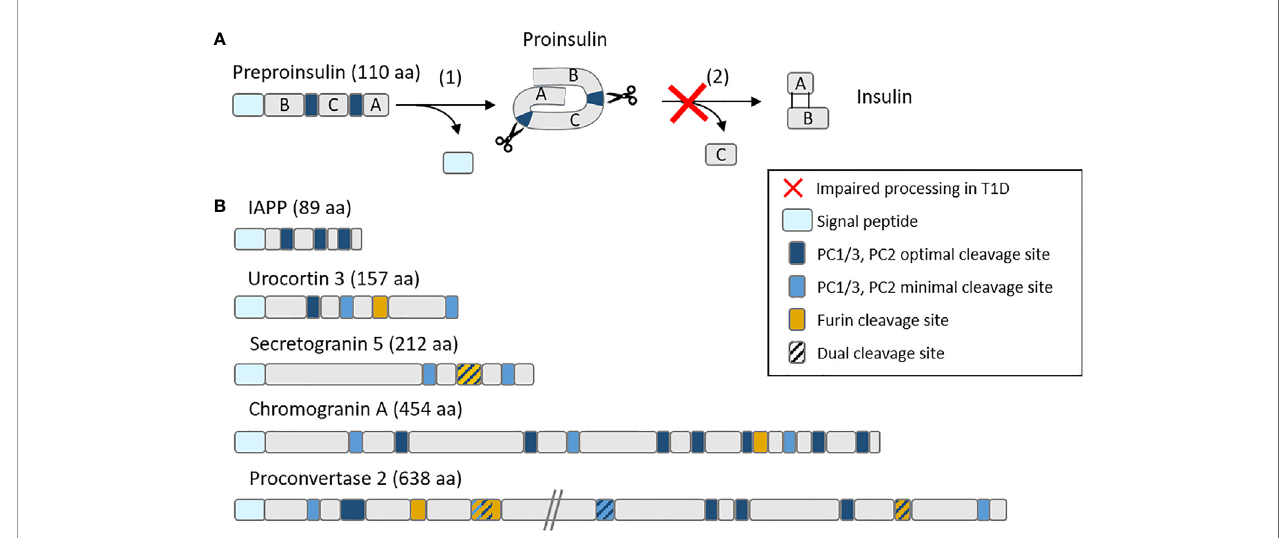
FIGURE 2 | Schematic representation of (A) the insulin maturation process and (B) mapping of proconvertase cleavage sites within insulin granule proteins. (A) Insulin is translated as a preprohormone comprising a signal peptide (light blue), followed by the B chain, C peptide and A chain. The fi rst processing step (1) consists in the cleavage of the signal peptide, followed by (2) the cleavage by proconvertases of the C peptide and formation of disul fi de bonds between the A and B chain. In T1D, this second step is often impaired, leading to proinsulin accumulation. (B) PC1/3 and PC2 optimal (RR, KR) and minimal (KK, RK) cleavage sites along with furin cleavage sites (R-X-X-R) (where X is any amino acid) are mapped on major insulin granules proteins. aa, amino